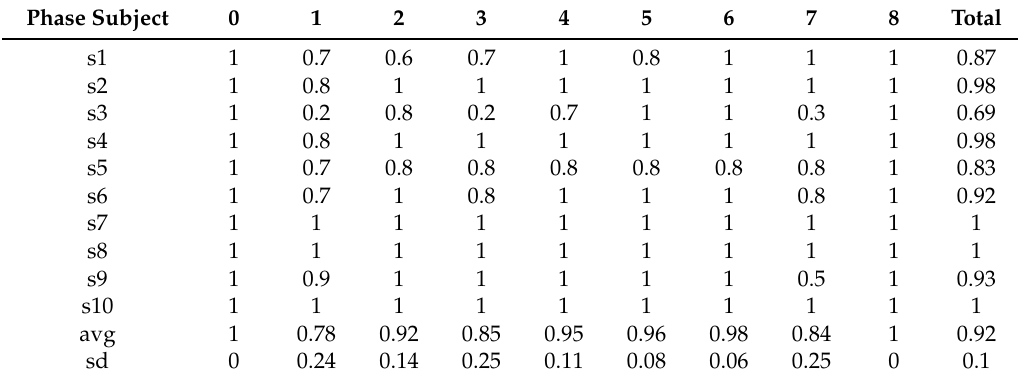
Table 4. Signal reliability